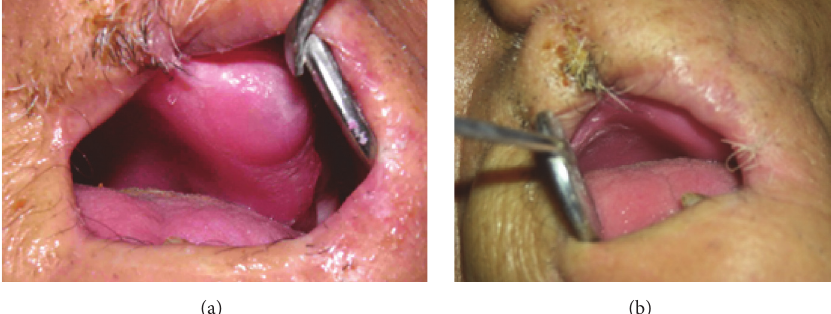
Figure 10: (a) Left lateral view showing implant-retained obturator in place; (b) midpalatal view indicating closed defect.